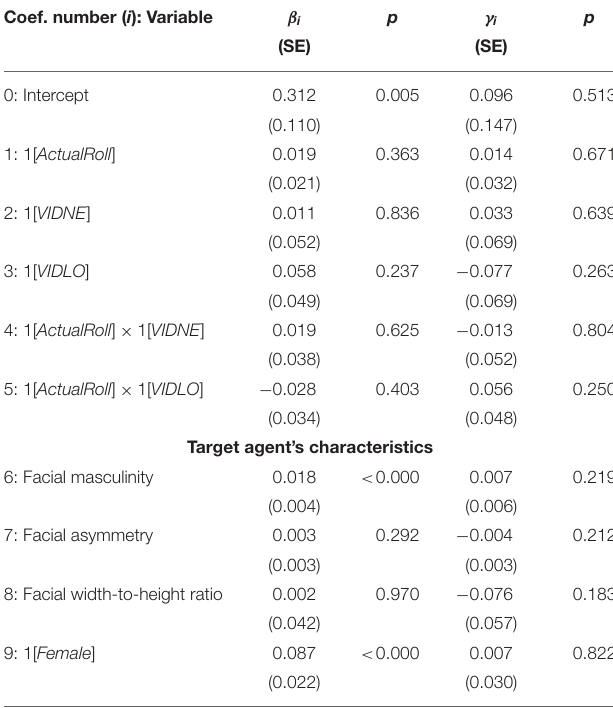
TABLE 3 | Predicted vs. actual behavior: regression analysis. PHOTO VIDNE